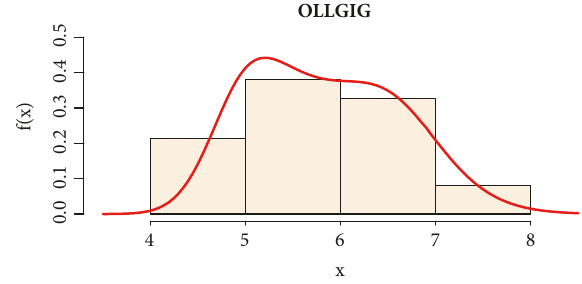
Figure 6: Estimated densities of the OLLGIG for iris data.